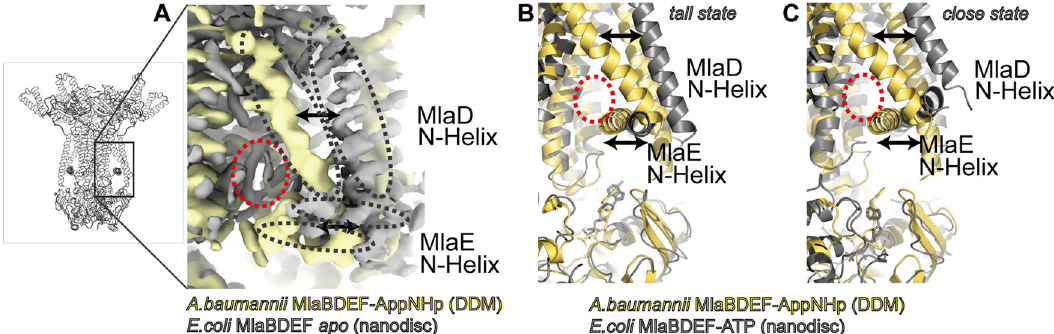
Fig. 5 Comparison of the MlaBDEF ab and MlaBDEF ec structures. The cryo-EM map of MlaBDEF ec in lipid nanodiscs 19 and of MLABDED ab in a DDM micelle (this study) show large differences in the lower lipid binding sites. A Both the MlaD N-terminal helix and the MlaE N-terminal helix form a much smaller pocket (red circle) in detergent environment (yellow, this study) compared to lipid environment (grey, EMD-30355). Two states were observed in the MlaBDEF ec study; tall ( B ) and close ( C ). Comparison between MlaBDEF ec and MlaBDEF ab shows that the pocket is smaller in both conformations, whereas the nucleotide position is identical in all three